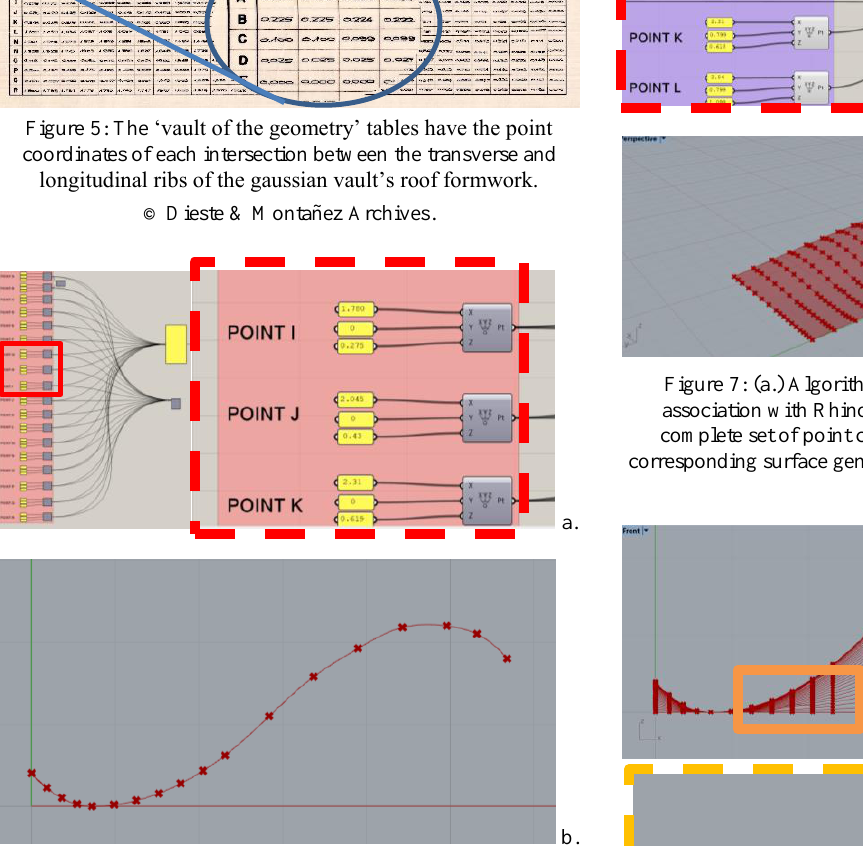
Figure 6: (left) Algorithm developed in the software Grasshopper© in association with Rhinoceros 3d 6.0© which extracted the point coordinates of the gaussian vault roof surface’s key transverse section, whose curve is displayed at the Rhinoceros interface (right).